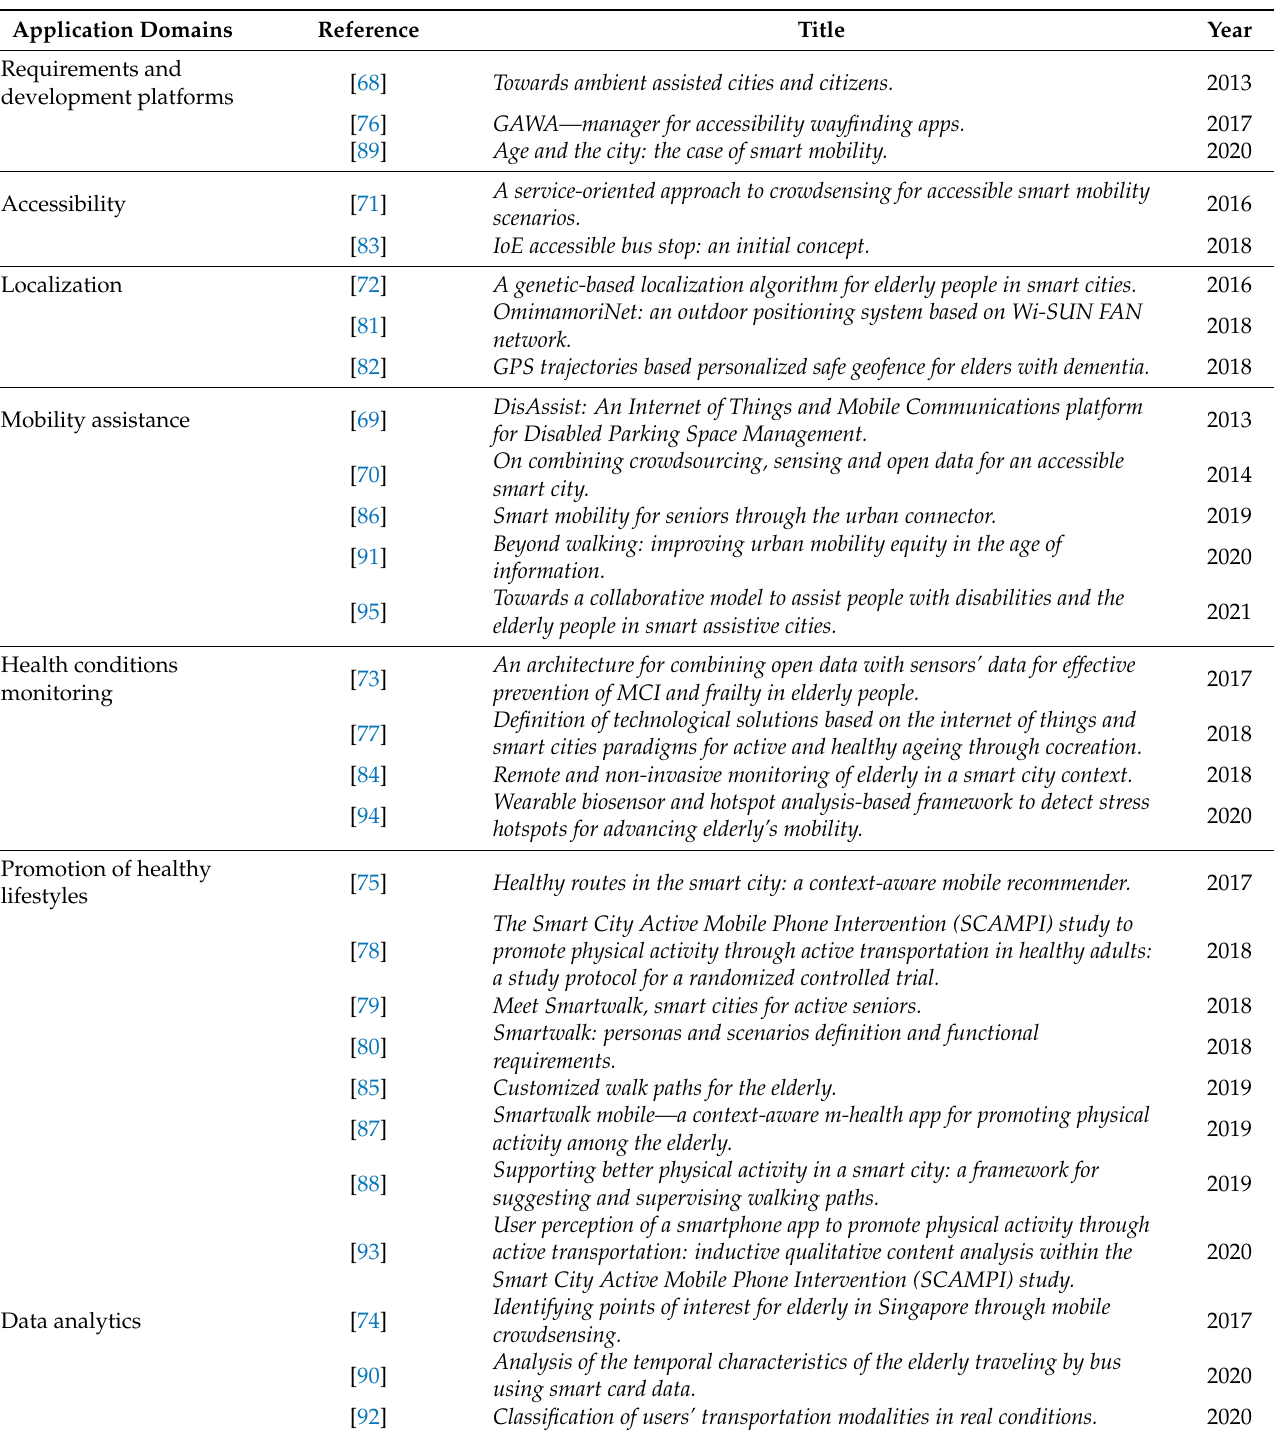
Table 3. Classification of the included